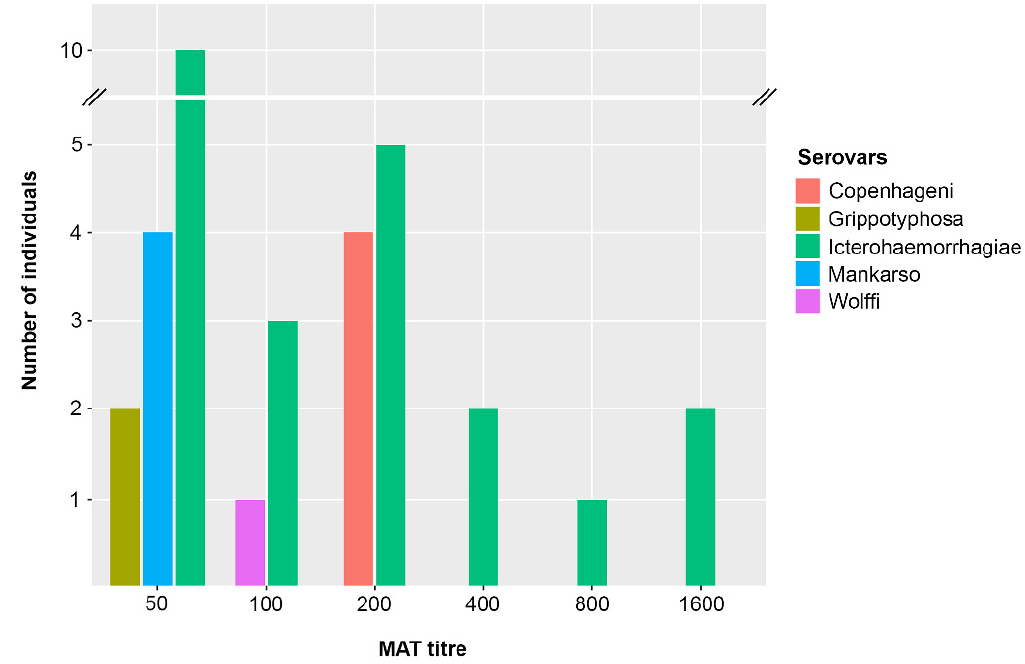
Figure 1. Distribution of the microscopic agglutination test (MAT) titers in rats. The initial starting titer was 1:50.